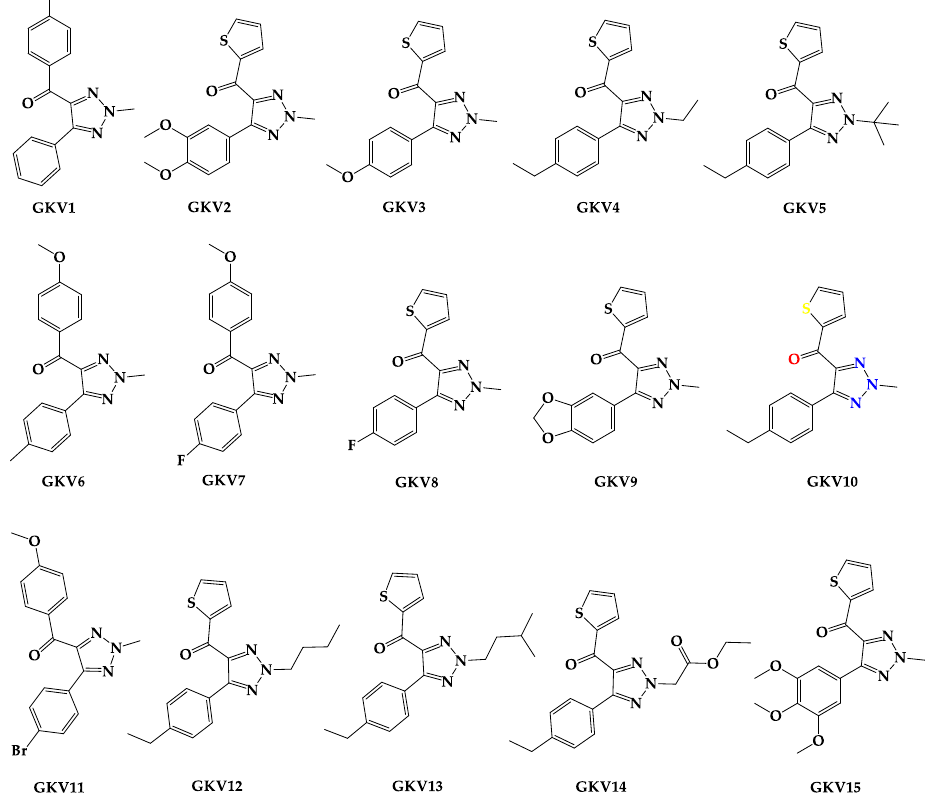
Figure 1. The molecular structures of 1,3,4-trisubstituted-1,2,3-triazole analogues (GKV1–15) studied